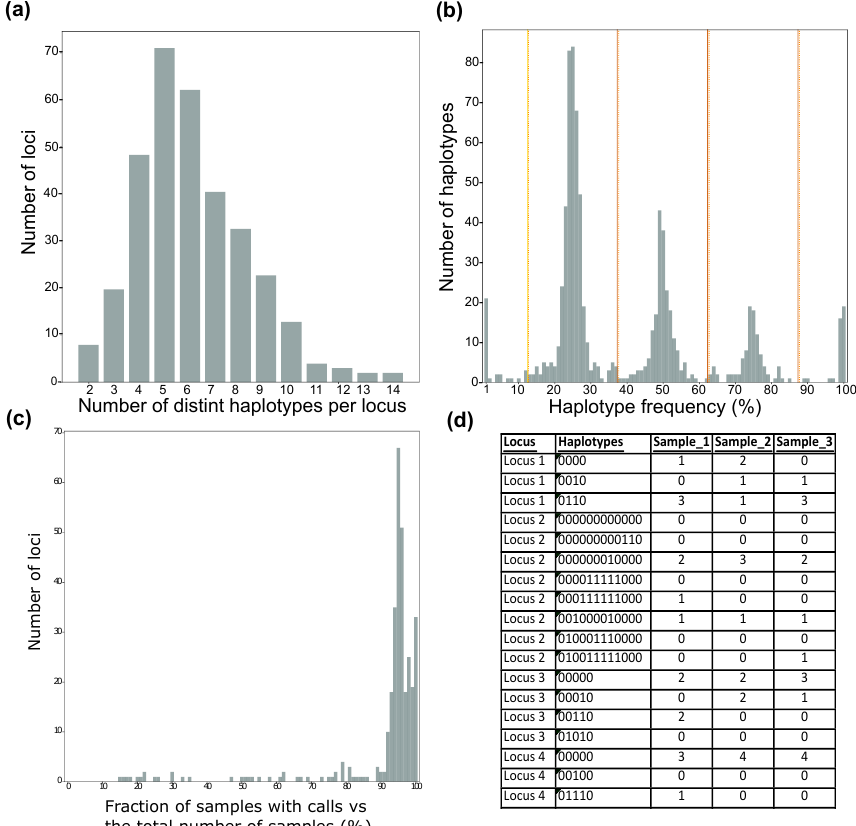
Figure 6. ( a ) Haplotype diversity distribution of 333 loci across the 765 individuals in the dataset generated by the non-normalized library. ( b ) Haplotype frequency spectrum of one individual cv. Gravity. ( c ) Locus call completeness; Distribution of samples across the locus set. ( d ) Example of tabular data generated by SMAP haplotype-sites with 3 samples, 4 loci, 18 haplotypes, and tetraploid discrete dosage calls for each